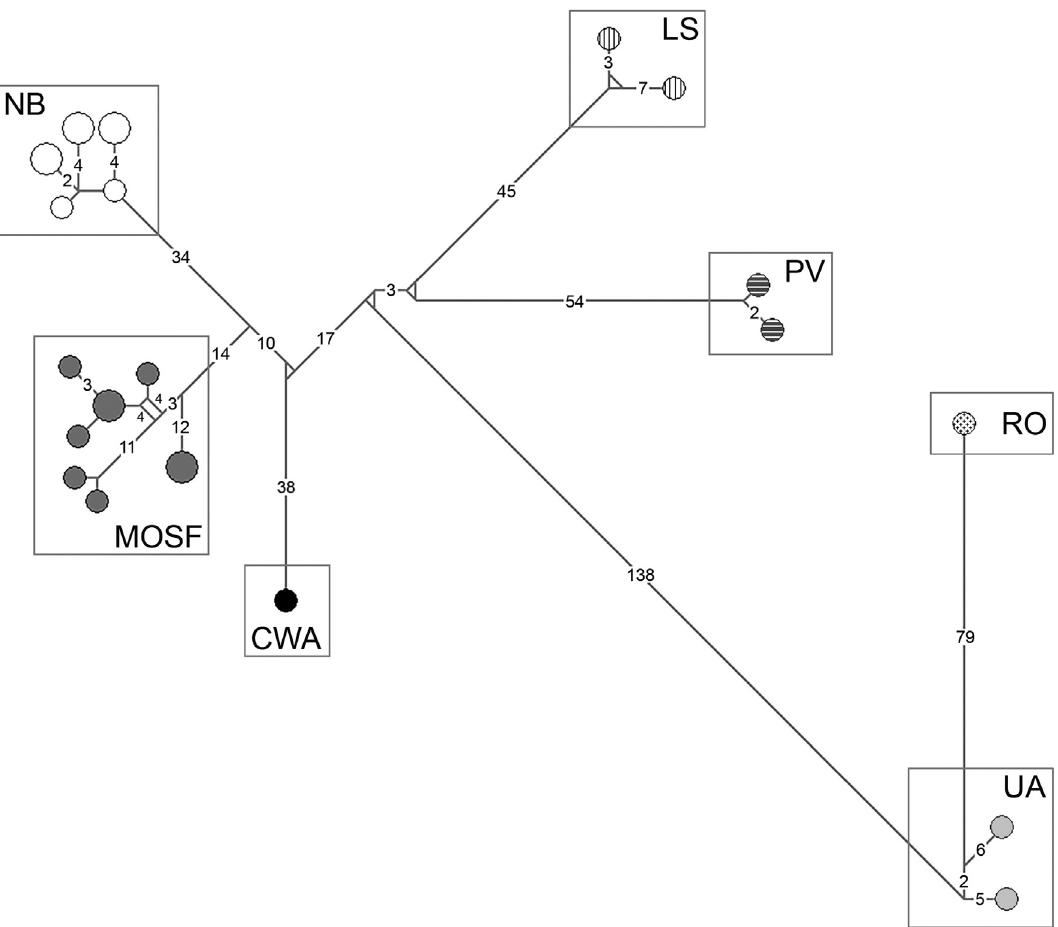
Figure 2 - Mitochondrial haplotype network showing seven geographic clusters. The network was constructed with concatenated mitochondrial data us- ingthemedian-joiningalgorithm.Circlesizesareproportionaltofrequencies,andmutationstepnumbersgreaterthanoneareindicatedonthelines.UA= Ucayali; RO = Rondônia; LS = Loreto and Santa Isabel do Rio Negro; PV = Porto de Moz and Vitória do Xingu; CWA = Colombia to the west of the An- des; MOSF = Manaus, Oriximiná, Suriname and French Guiana; NB = northeastern